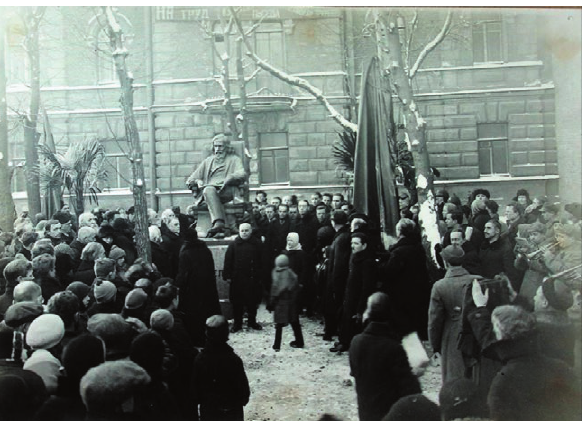
Figure 4. Inauguration of the monument to D. I. Mendeleev in the square of the Main Chamber of Measures and Weights. Photo of February 2, 1932 Photo from the collection of the Metrology Museum hosted by the D.I. Mendeleyev Institute for Metrology. Note. The figure (bronze, granite) is 1.86 m, the pedestal of